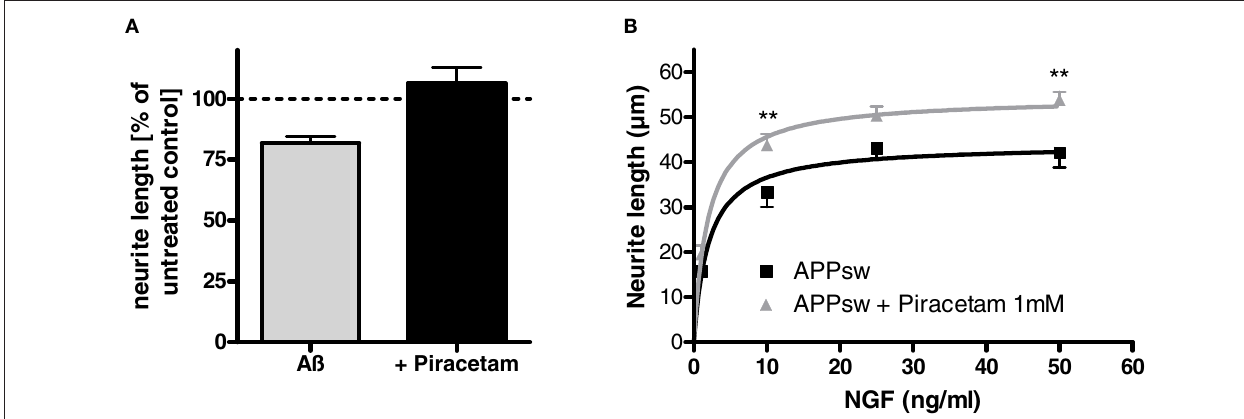
outgrowth was measured. In the presence of different NGF concentrations (1–50 ng/ml) piracetam improved the neurotrophic effect of NGF in APPsw cells. All data are modified after Kurz et al. (2010). Data are expressed as mean ± SEM ( n = 6–7) ** p < 0.01, *** p < 0.001 vs. the respective control, two-way anova with bonferroni post